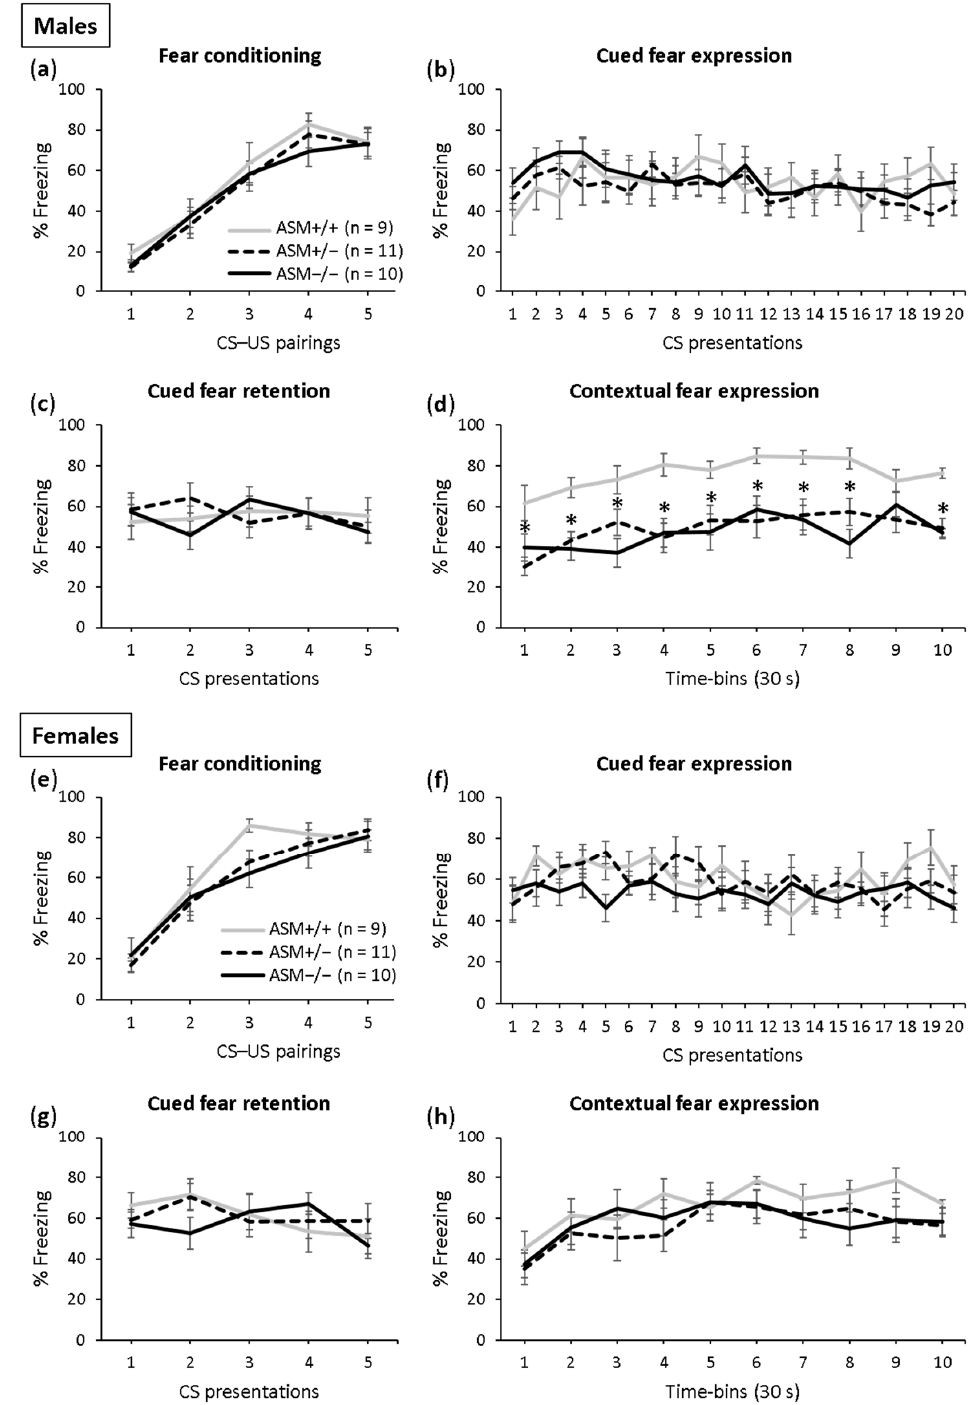
Figure 3. Acid sphingomyelinase (ASM) deficiency decreases the expression of contextual fear in male mice. ( a , e ) On day 1, the homozygous (ASM − / − ) and heterozygous (ASM+/ − ) ASM deficient mice and wild-type littermates (ASM+/+) were fear conditioned in context A; ( b , f ) on day 2, the expression of cued fear (i.e., tone-elicited freezing) was assessed in context B; ( c , g ) on day 3, the retention of cued fear was assessed in context B; ( d , h ) on day 4, the expression of contextual fear was assessed in context A. Data represent the mean time of CS-elicited freezing ± SEM, and numbers in parentheses indicate group sizes. * p < 0.05 compared with ASM+/+ mice.